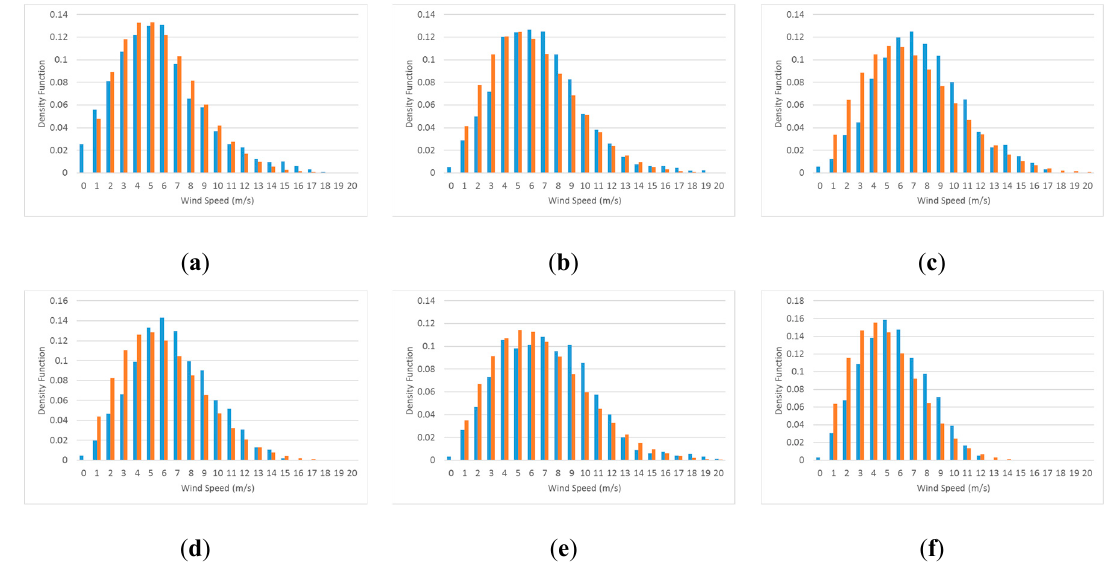
Figure 9. Six groups of samples of normalized histograms of wind speeds, in blue, and fitted Weibull distribution, in orange, for group periods of 25 days each during WS season. Each graph corresponds to the following period ( a ) 01/01/2010–01/25/2010; ( b ) 01/26/2010–02/19/2010; ( c ) 02/20/2010–03/16/2010; ( d ) 03/17/2010–04/10/2010; ( e ) 04/11/2010–05/05/2010; ( f ) 05/06/2010 – 05/30/2010.